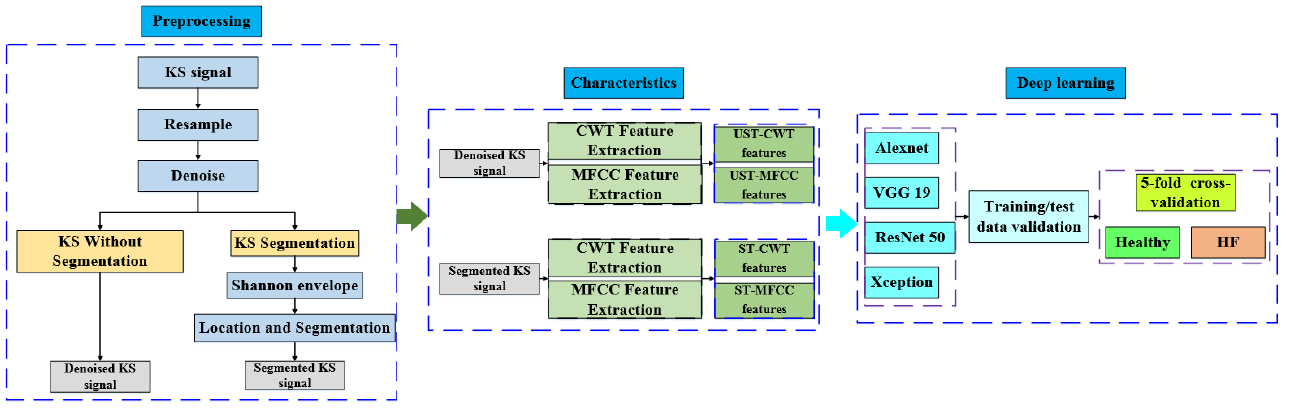
Figure 1. The overall structure of this